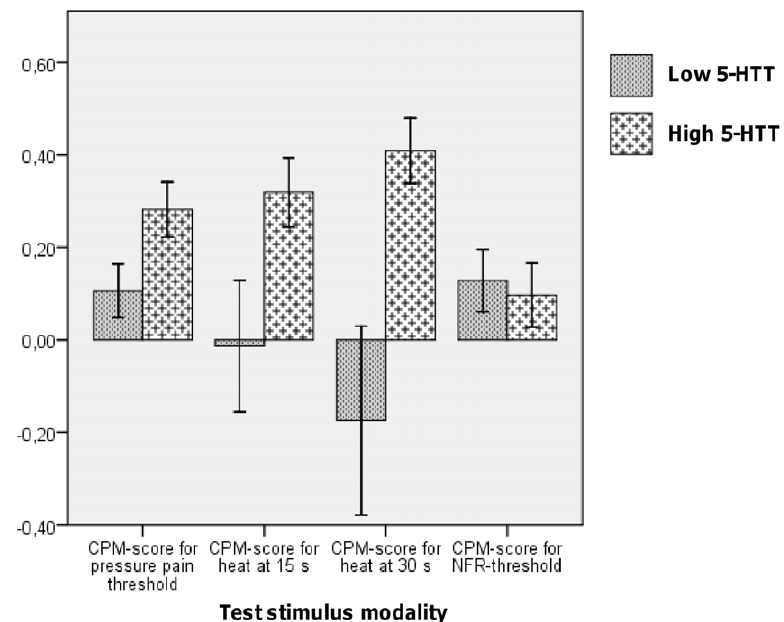
Figure 3. Conditioned pain modulation. The low 5-HTT-expressing group, as compared with the high 5-HTT group, had a significantly diminished conditioned pain modulation with regard to pressure pain thresholds [F(1,41)=5.99, p=0.02] and heat at 30 seconds [U=145.5, z= 2 2.44, p=0.02, r= 2 0.36]. There were no significant differences between groups with regard to tonic pain-mediated increase in the threshold for the nociceptive flexion reflex (NFR), F , 1.